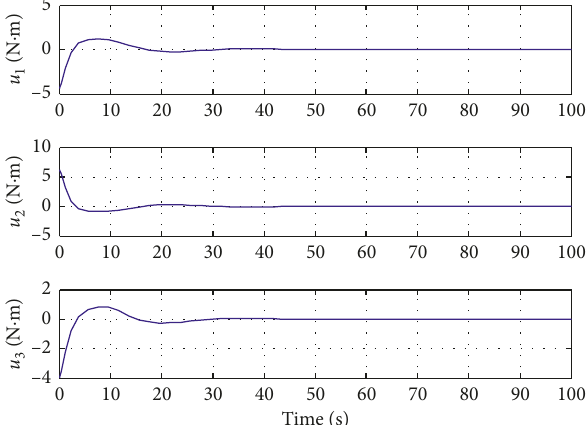
Figure 3: Time response of control input u when Φ � 200 ∘ .